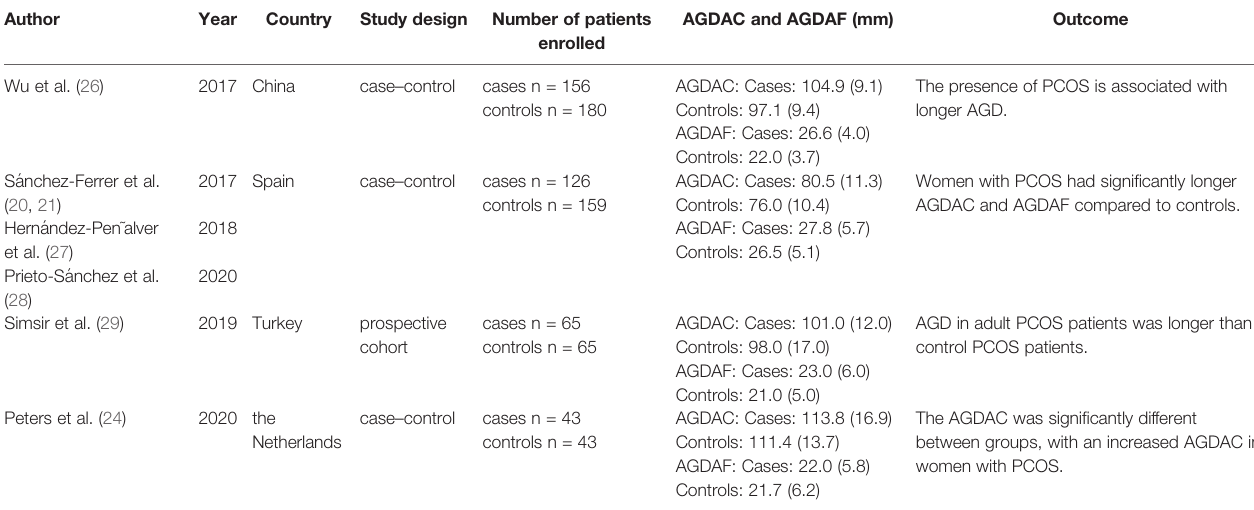
TABLE 2 | Studies evaluating anogenital distance in women with polycystic ovary